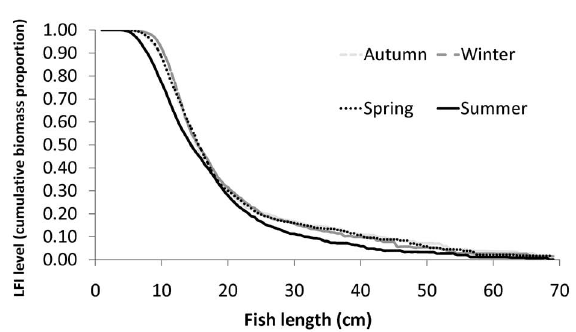
Fig. 3. – LFI curves for the 2008-12 trawler catch in winter (Jan- Mar), spring (Apr-Jun), summer (Jul-Sep) and autumn (Oct-Dec).